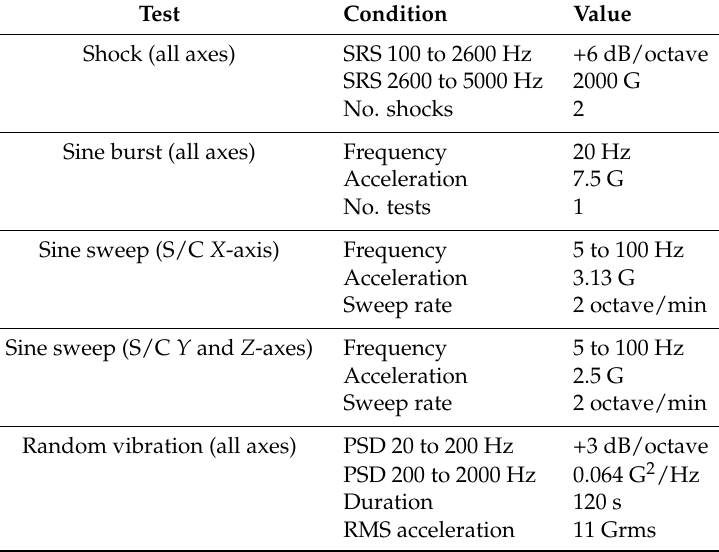
Figure 6. The sequence of mechanical tests conducted on the qualification model of the solar panel. The same sequence also applies to the satellite EQM test, but modal survey was carried out after each test during the satellite system-level tests. Table 5. Mechanical qualification test conditions used to test the SMIC. X refers to the satellite longitudinal (aligned with the launch vehicle acceleration) axis, while Y and Z axes complete the orthogonal